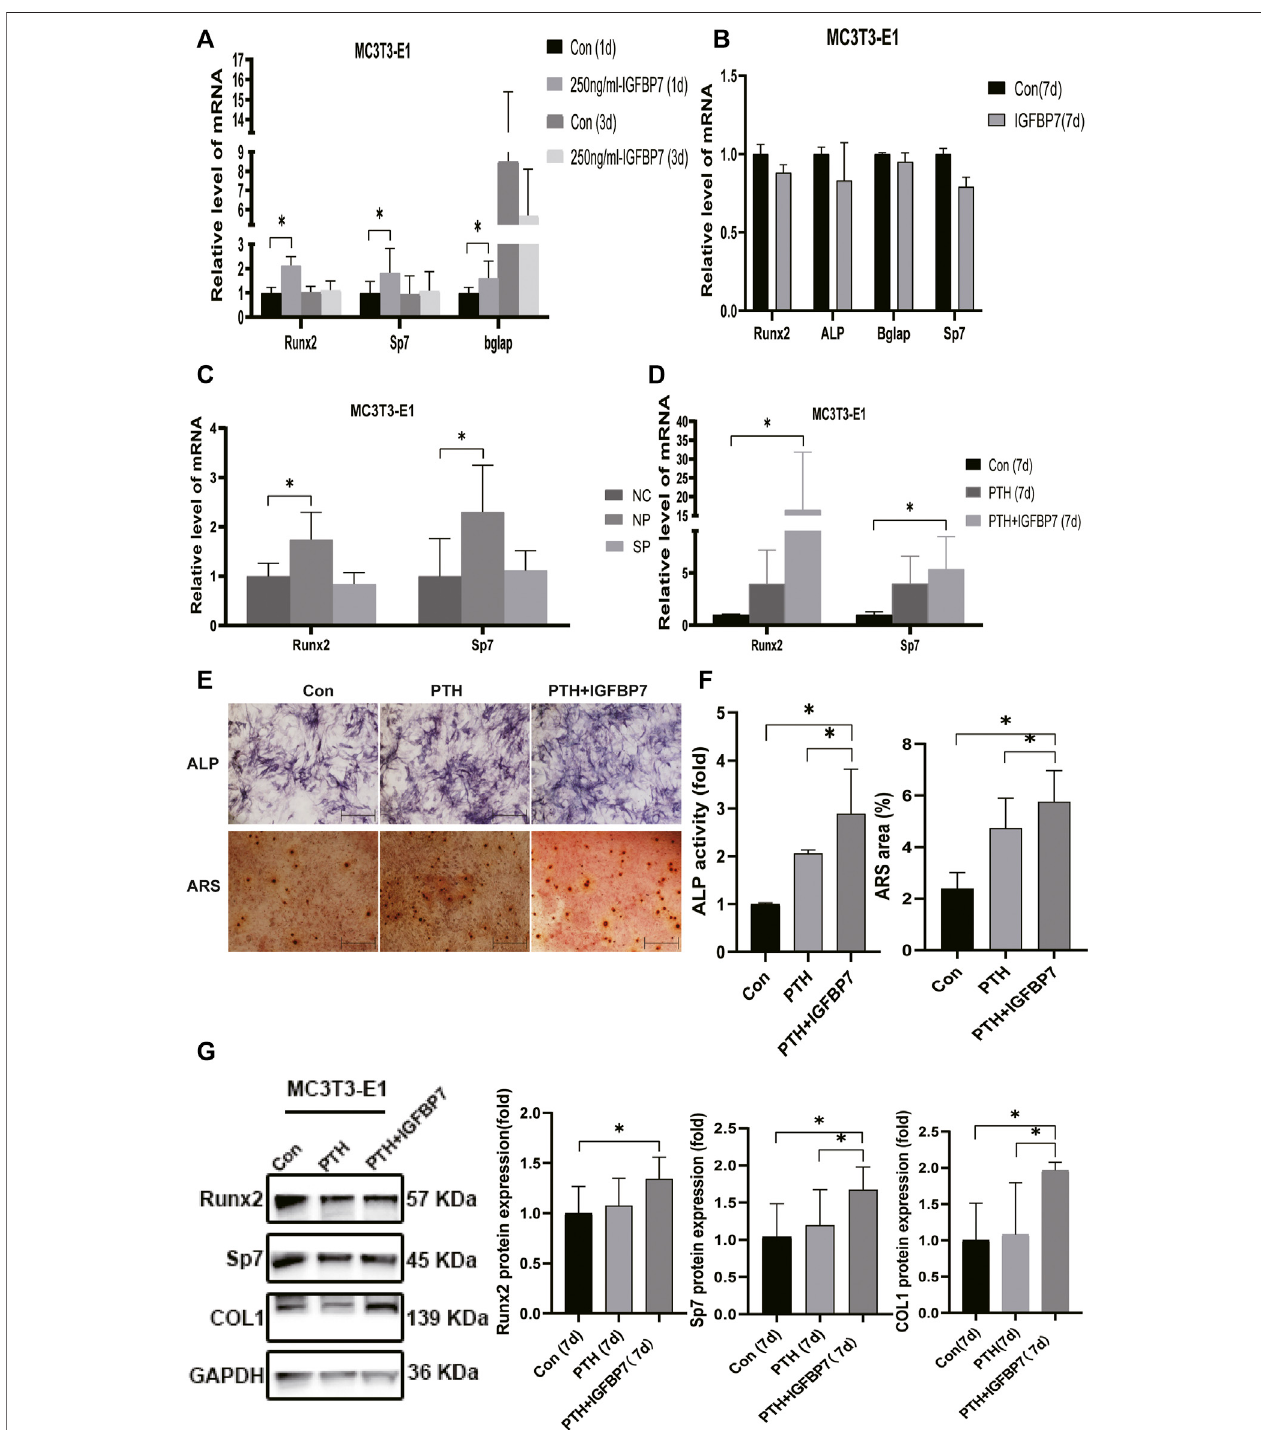
FIGURE 4 | Impacts of IGFBP7 on osteogenic differentiation of MC3T3-E1 cells induced by iPTH. (A) The mRNA expression of osteogenic marker genes induced by 250 mg/ml IGFBP7 for d one and d 3. (B) Relative mRNA expressions of osteogenic marker genes in IGFBP7 group on d7. (C) Relative mRNA expressions of osteogenicmarkergenesinducedbyiPTH for4/24 hon d1after transfection inMC3T3-E1cells inthenegativecontrolgroup (NP) andIGFBP7 silenced group (SP). (D) RelativemRNAexpressionsofosteogenicmarkergenesinducedbyiPTHalone(PTHgroup)andIGFBP7combinedwithPTH(PTH+IGFBP7group)for7 days. (E) ALPstainingonday7;Scalebars,400 μ m.Alizarinredstainingonday14;Scalebars,400 μ m. (F) quanti fi cationofALPactivity andcalciumdepositioninducedbyiPTH alone (PTH group) and IGFBP7 combined with PTH (PTH + IGFBP7 group). (G) Relative protein expressions of Runx2, Sp7, and COL1 in MC3T3-E1 cells induced by iPTH alone (PTH group) and IGFBP7 combined with PTH (PTH + IGFBP7 group) for 7 days * p < 0.05.